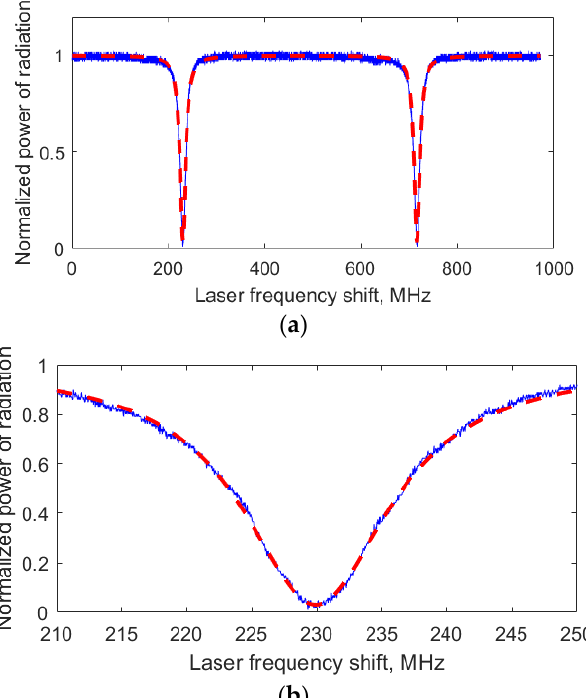
Figure 5. Experimentally (blue solid curve) and analytically (red dashed line) obtained frequency characteristics of mode 1 of the first resonator ( a ) and the same on a different scale ( b ). Using expression 15, the limiting sensitivity of the proposed method was evaluated when using the described resonators. At Pin = 2.5 mW and Δ ν = 1 Hz, it was 3.2 °/h for the first and 1.8 °/h for the second resonator.